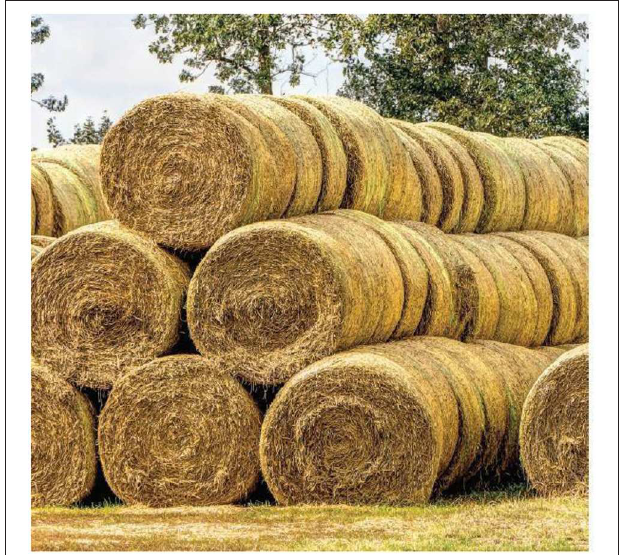
FIGURE 2 | Solid biofuel made from compacted crop straw (Royal Academy of Engineering, 2017).